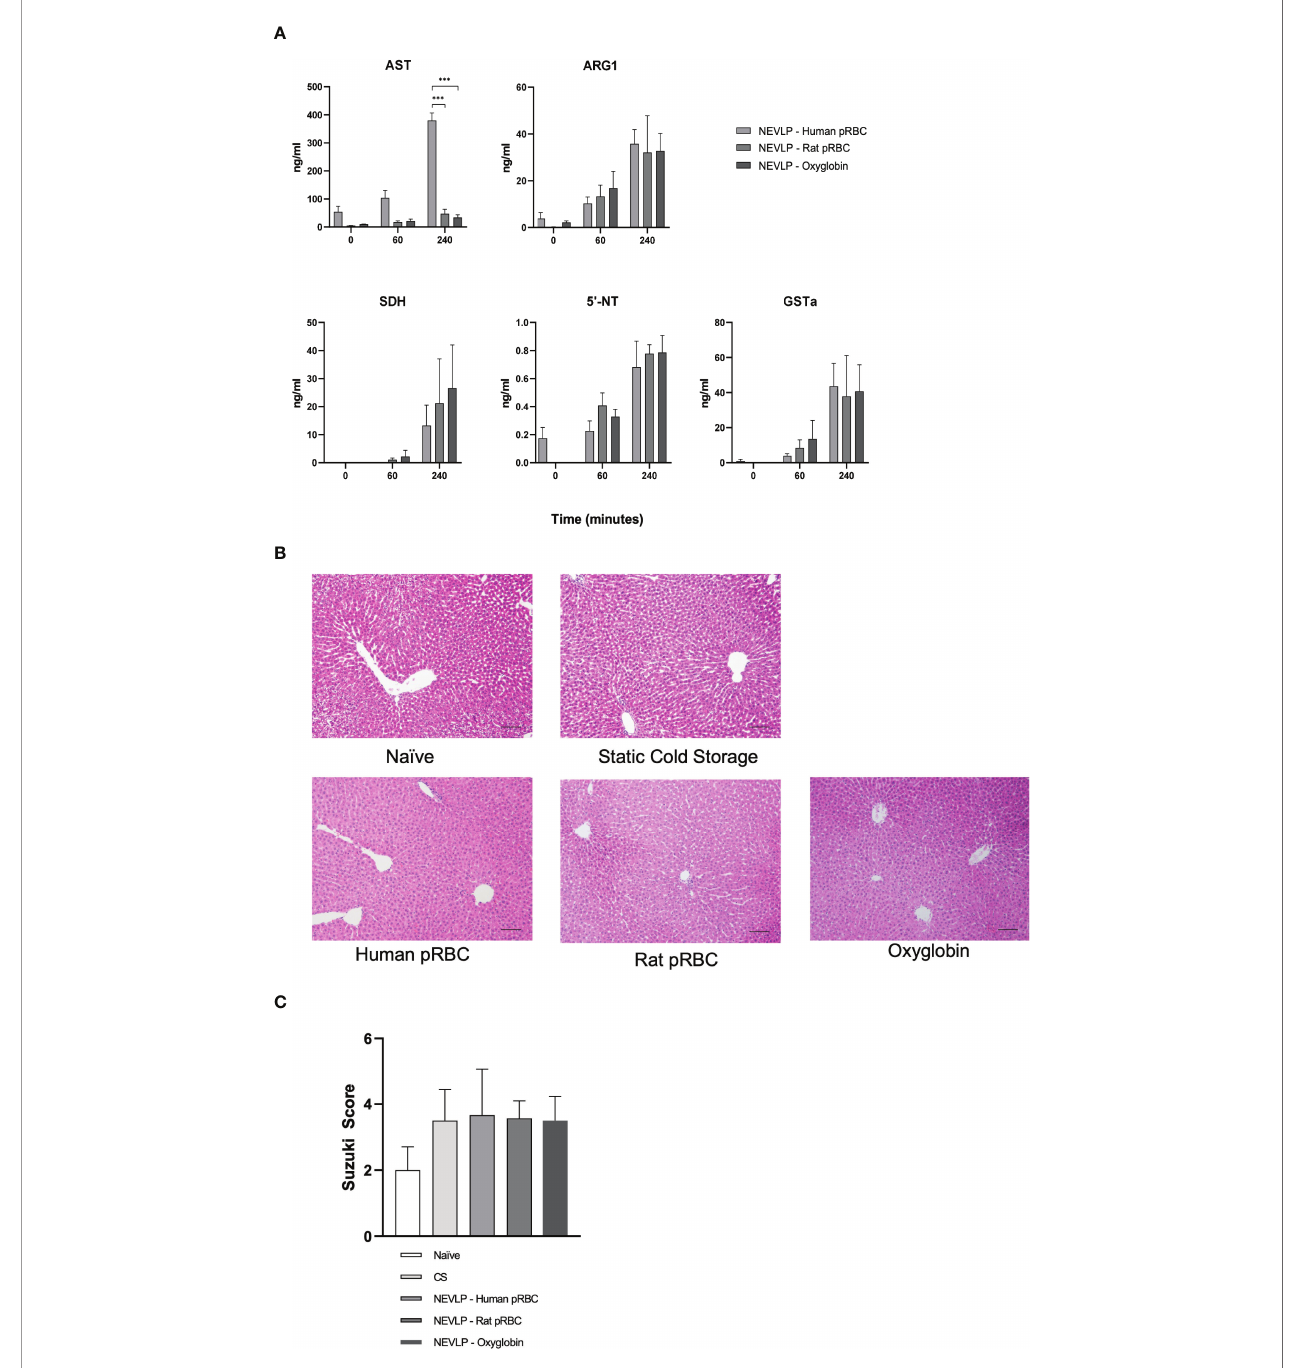
FIGURE 3 | Oxygen carriers have no effect on liver damage during NEVLP. Liver injury was assessed by the presence of liver damage-associated enzymes in the perfusate and histology. (A) Markers of liver damage were measured in the perfusate hourly and at the conclusion of NEVLP. These experiments showed elevations in AST in the human RBC oxygen carrier group. Perfusate samples from one human pRBC and one rat pRBC NEVLP experiment were mislabeled, and timing could not be con fi rmed. Therefore, these samples were omitted from perfusate analysis (data consist of n = 5 for human pRBC, n = 3 for rat pRBC, and n = 5 for the Oxyglobin group). (B) Representative micrographs of livers stained with H&E for each treatment group. (C) Quantitative analysis of liver damage using the Suzuki criteria. No signi fi cant differences were found between treatment groups, and overall levels of damage were low. ***p <